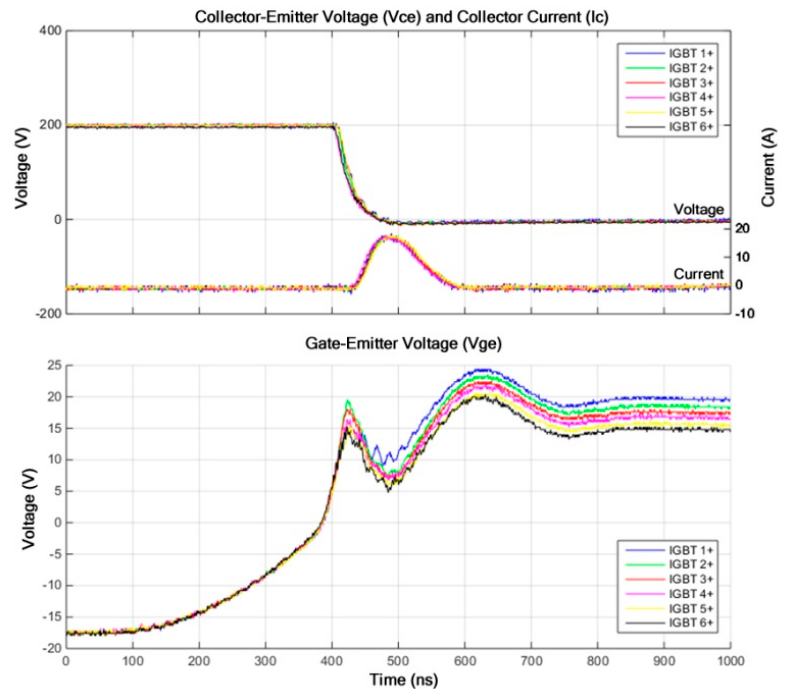
Figure 15. Turn-on switching with no-load current, showing the current of the snubber’s circuits (negative side devices). The perfect balance of the Vce voltages of the devices was verified.